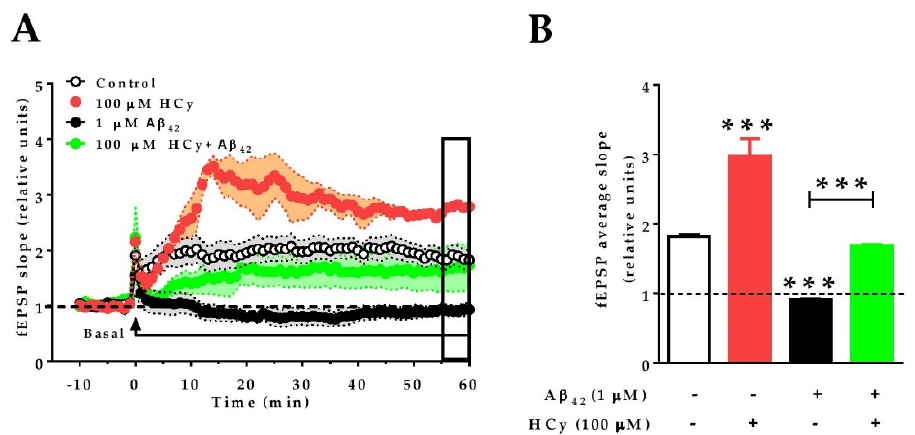
Figure 5. HCy increases the excitability of A β 42 -treated hippocampal slices. Recording of fEPSP amplitudes. ( A ) After 10 min of basal recording, long-term potentiation (LTP) was induced by theta burst stimulation (TBS) (arrow). At the same time, the correspondent treatment (control aCSF, 100 µ M HCy, 1 µ M A β 42 , or HCy + A β 42 ) begins perfusion. Treatments were continuously administered, as shown by the horizontal line, for 60 min. The empty box at the end of the recording represents the last 5 min of data acquisition. ( B ) Quantification of the average fEPSP in the last 5 min of recordings. Bars are the mean ± SEM for three independent experiments with a minimum of eight di ff erent brain slices. A one-way ANOVA was performed followed by a Bonferroni post-test. Bars are the mean ± SEM. * p < 0.05, *** p < 0.001.